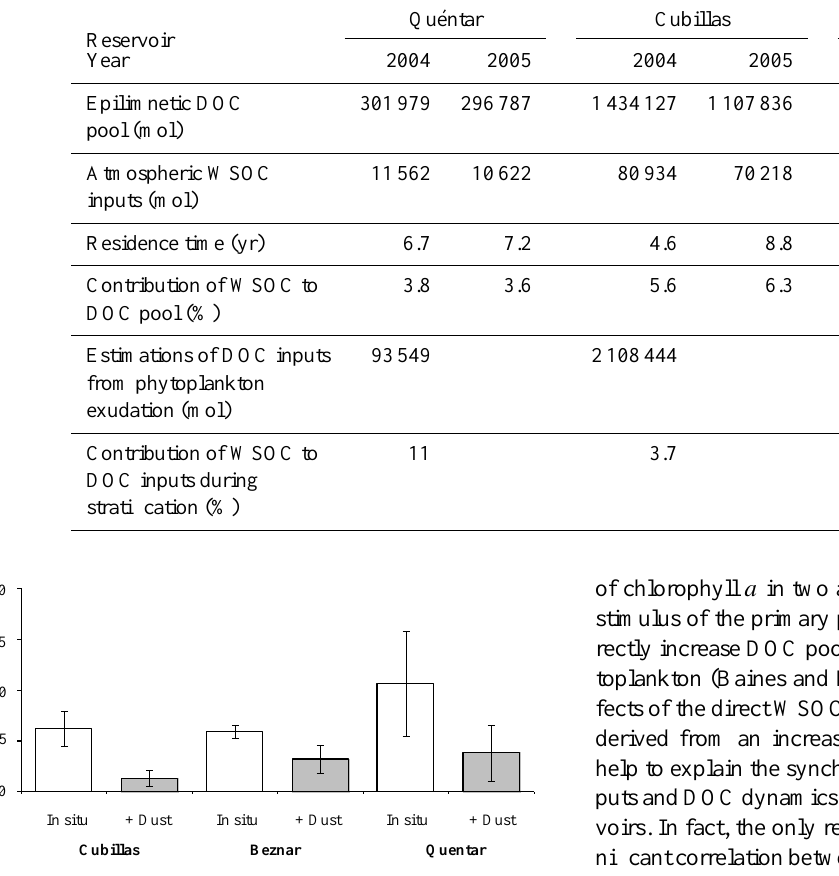
Fig. 6. Seasonal means (bars) and standard deviations (error bars) of the Z 10 % values during the stratification period of 2004 considering the in situ conditions (white bars) and including the extra absorption due to the inputs of chromophoric components (gray bars). Z 10 % values are the depths reached by the 10% of the surface incident radiation at 320nm in the epilimnion of the study